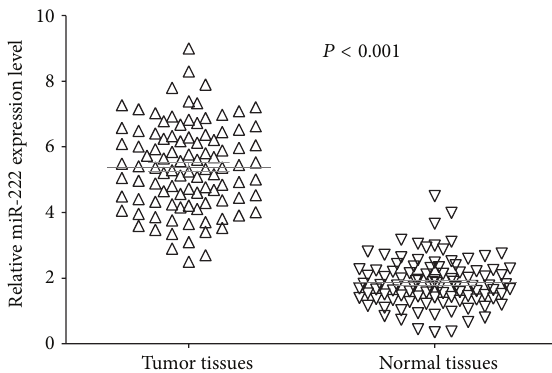
Figure 1: Comparison of miR-222 expression levels between NSCLC tissue and adjacent normal tissue. Analysis using two- sample Student’s 𝑡 -test showed that the relative expression levels of miR-222 in the NSCLC tissue were significantly higher than those in adjacent normal tissue ( 𝑃 < 0.001